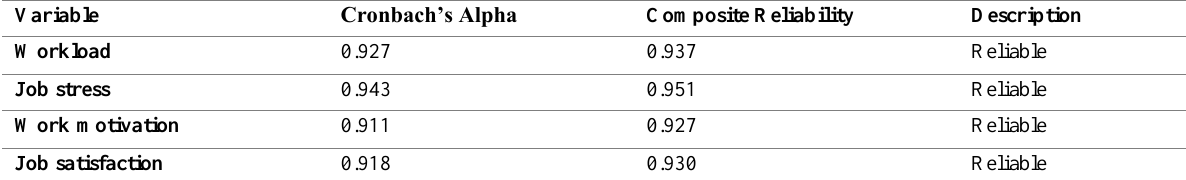
Table 3: Composite Reliability Test